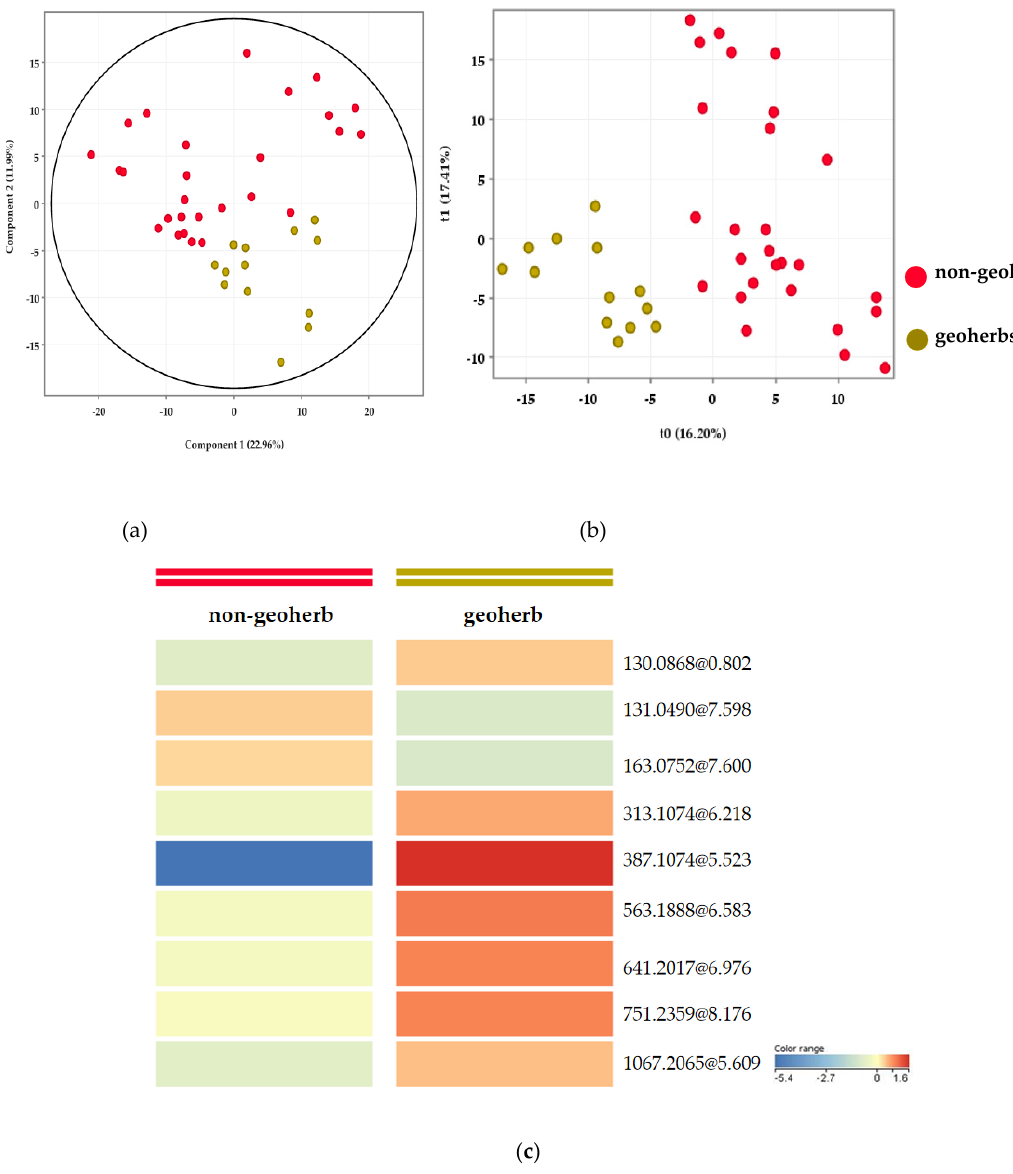
Figure 1. PCA scores ( a ), PLS–DA scores ( b ), and heatmap of nine characteristic chemical markers ( c ).